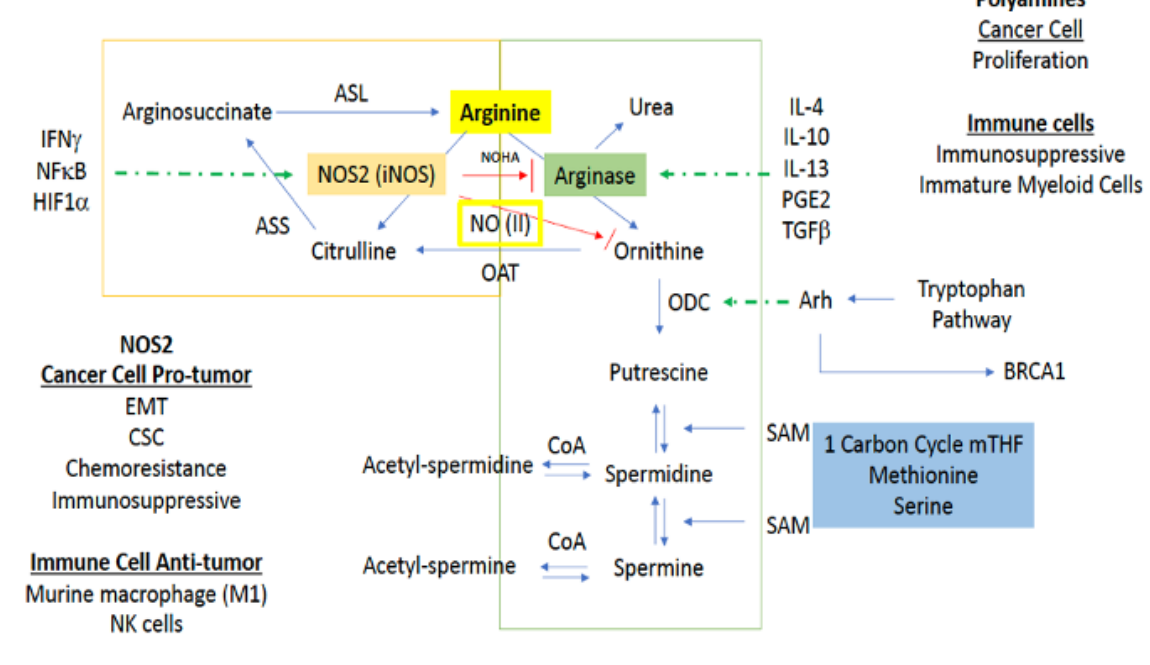
Figure 5. Downstream signaling pathways affected by NOS2/NO activity. Red arrows indicate inhibition while blue arrows indicated activation.